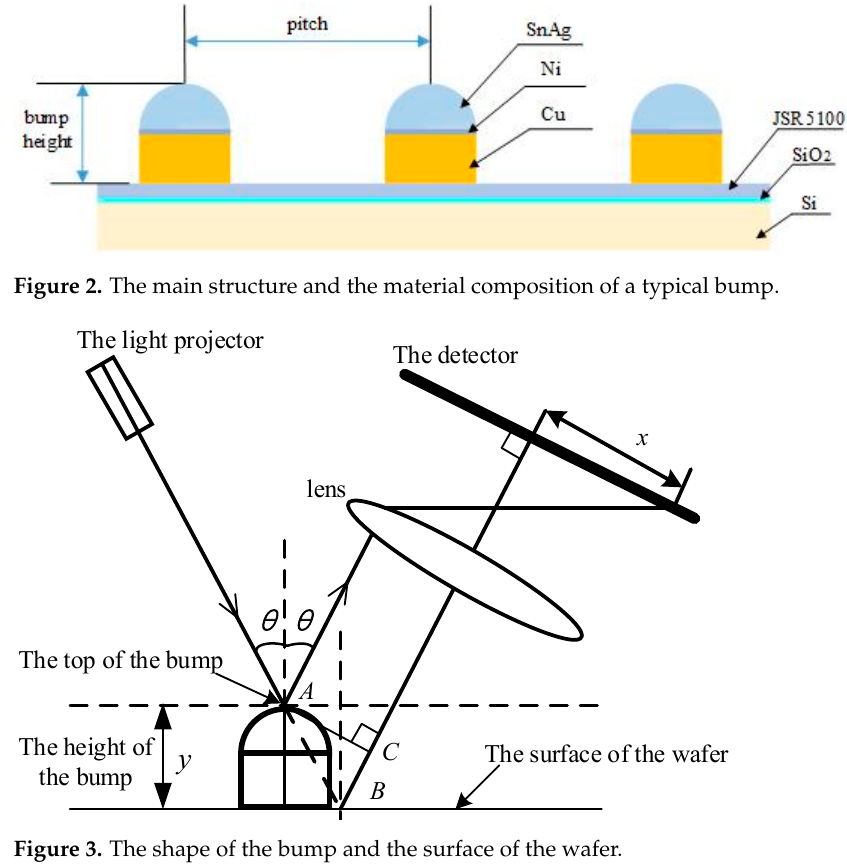
Figure 3. The shape of the bump and the surface of the wafer.